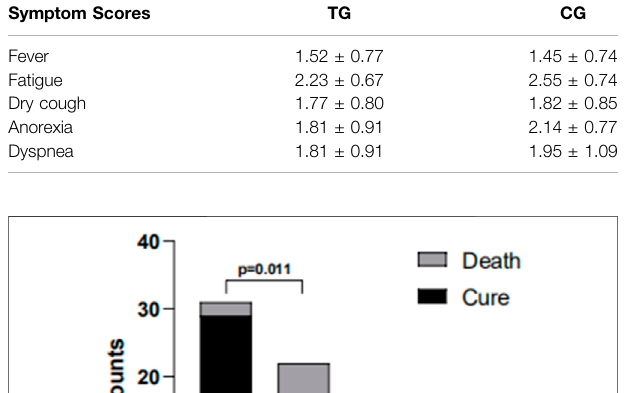
TABLE2| SymptomseverityofthehemodialysispatientsaffectedbySARS-CoV2 infection. Symptom Scores